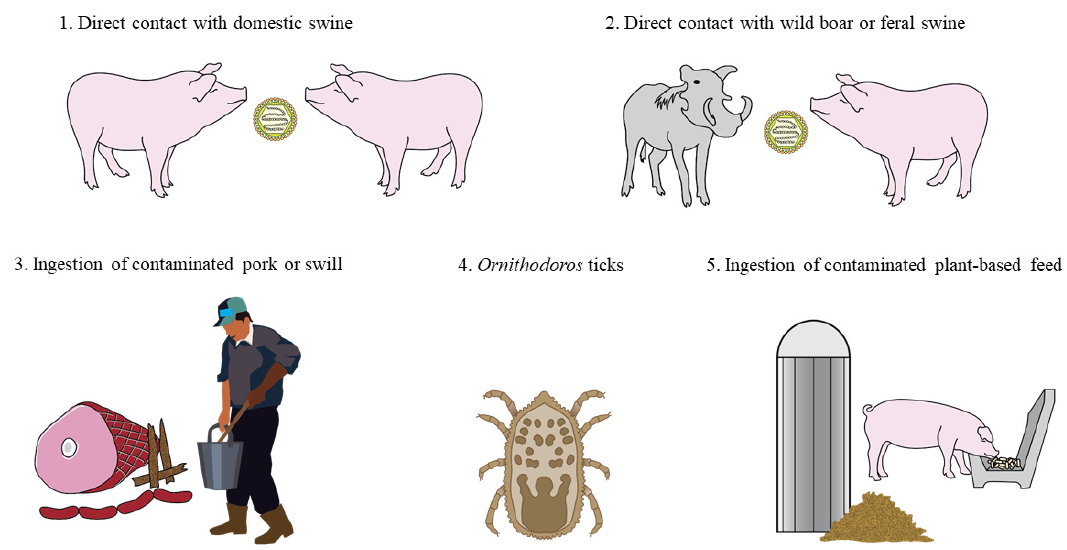
Figure 1. Routes of African swine fever virus (ASFV) transmission. Figure depicts potential modes of ASFV transmission, including (1) direct contact with excretions and secretions from infected domestic swine, (2) direct contact with excretions and secretions from infected wild boar or feral swine, (3) natural oral consumption of uncooked contaminated pork products or swill, (4) vector-borne transmission through the bite of an infected soft tick ( Ornithodoros spp.), and (5) natural oral consumption of contaminated plant-based feed. Non-depicted modes of ASFV transmission include exposure to contaminated fomites, such as boots, clothing, pens, trucks, and other inanimate materials.